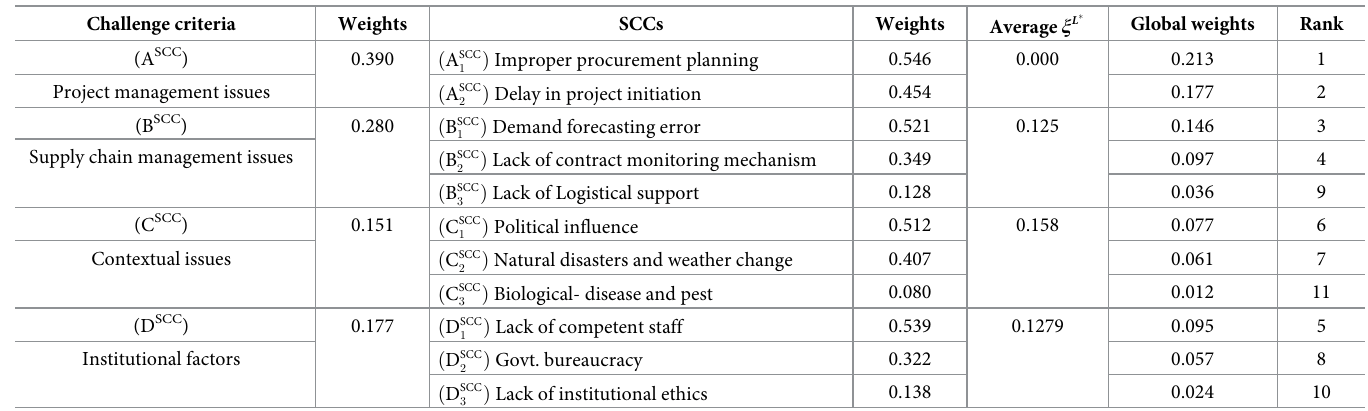
Table 3. Weights, and ranking of the SCCs obtained via BWM. Challenge criteria